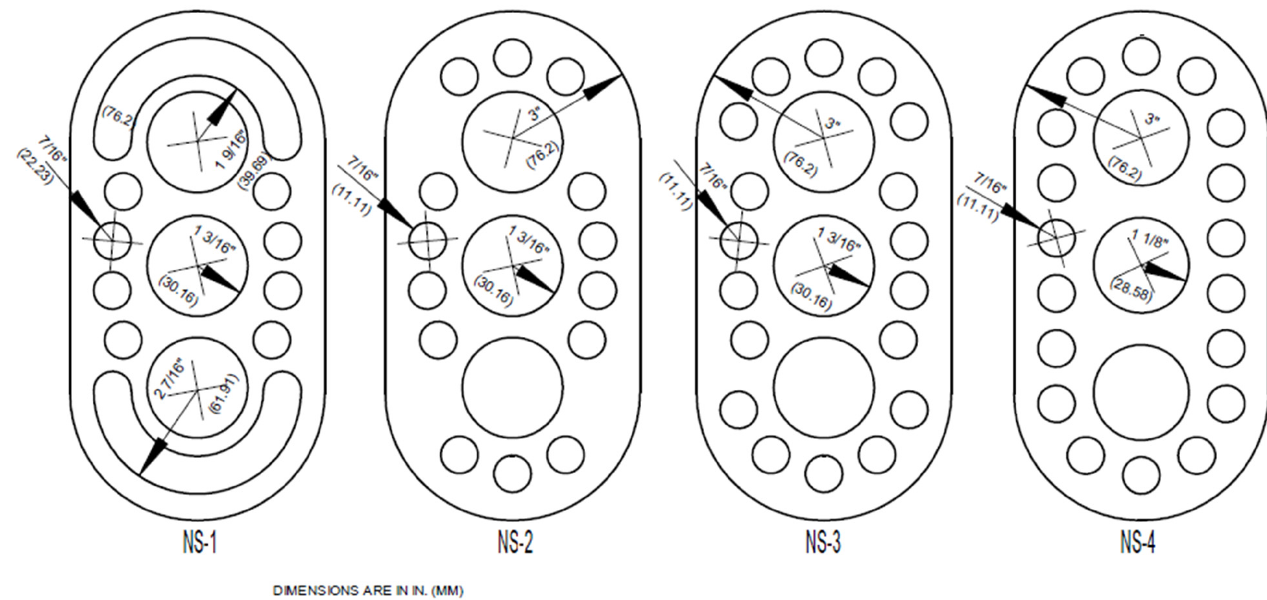
Figure 5. Shapes NS1 thru NS4.